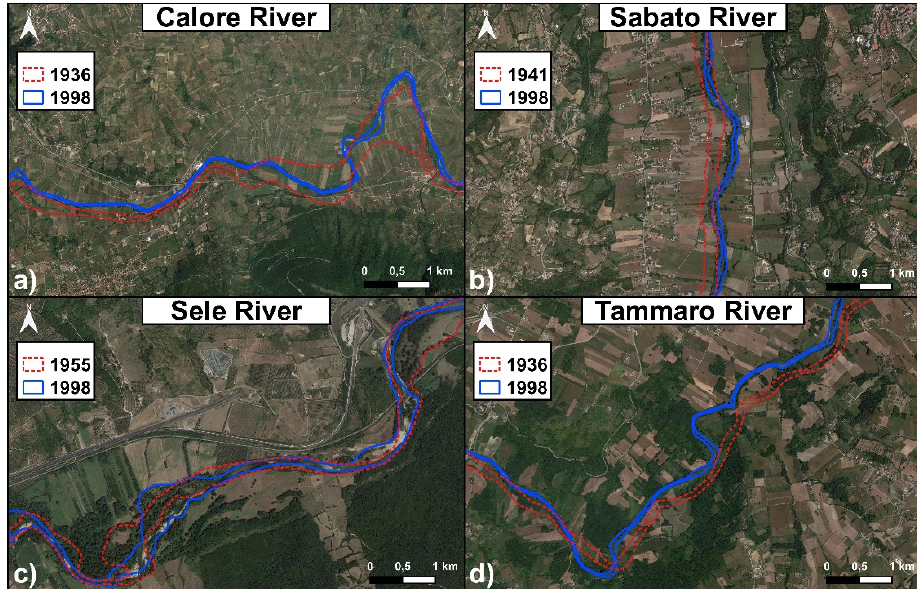
Figure 5. Geomorphological sketches of some selected river stretches showing the channel narrowing that affected the investigated rivers during Phase 2.